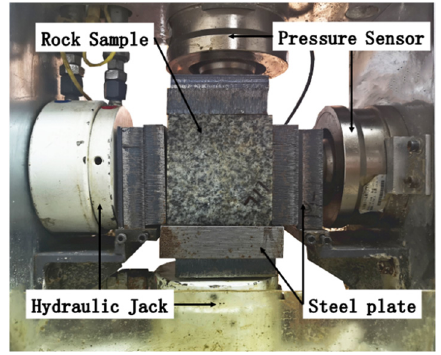
Figure 1. Laboratory servo-controlled drilling test platform.